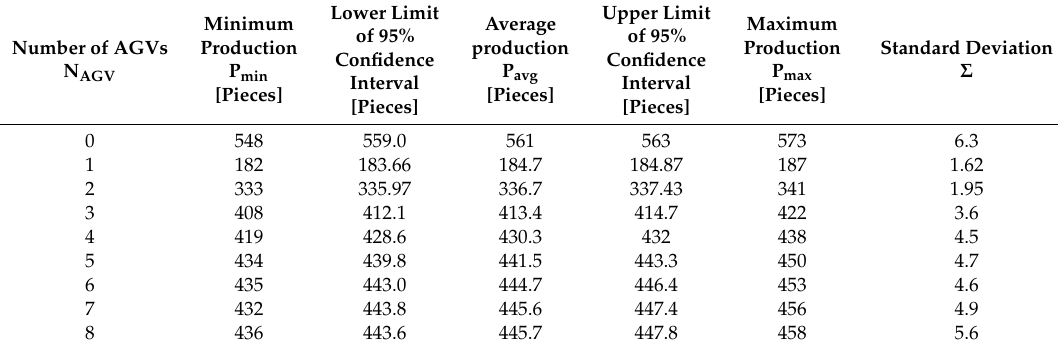
Table 1. The results of simulation experiments (Average production completed P avg , in [pieces] for 24 h of work, 30 simulation runs in each experiment, 95% confidence